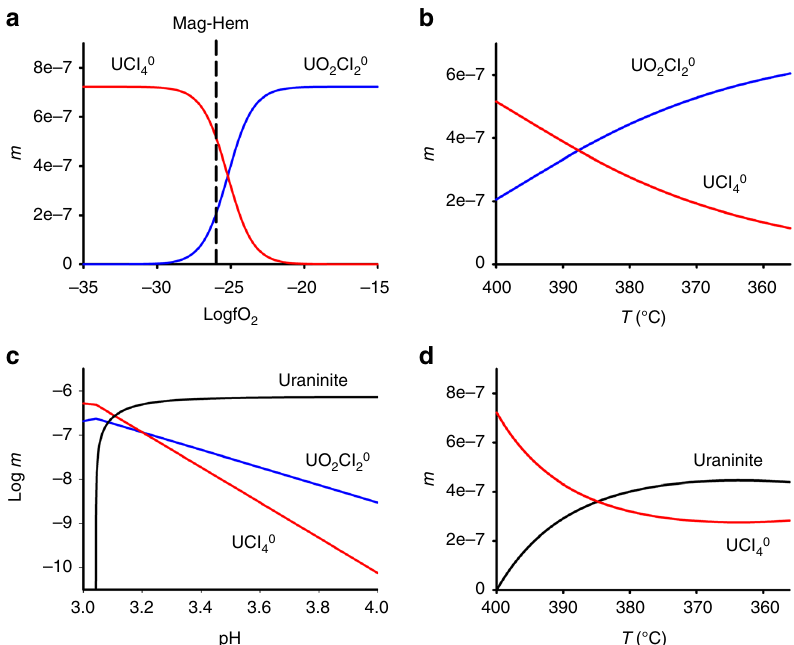
Fig. 3 A model of uranium behavior in a magnetite-bearing IOCG system. a , b Raising the oxygen fugacity of a 2 m NaCl acidic brine at 400 °C and 500 bar does not induce uraninite precipitation ( a ), nor does cooling under oxidizing conditions ( b ). c , d However, increasing the pH at oxidizing conditions ( c ) or decreasing the temperature of a reduced solution ( d ) triggers uraninite